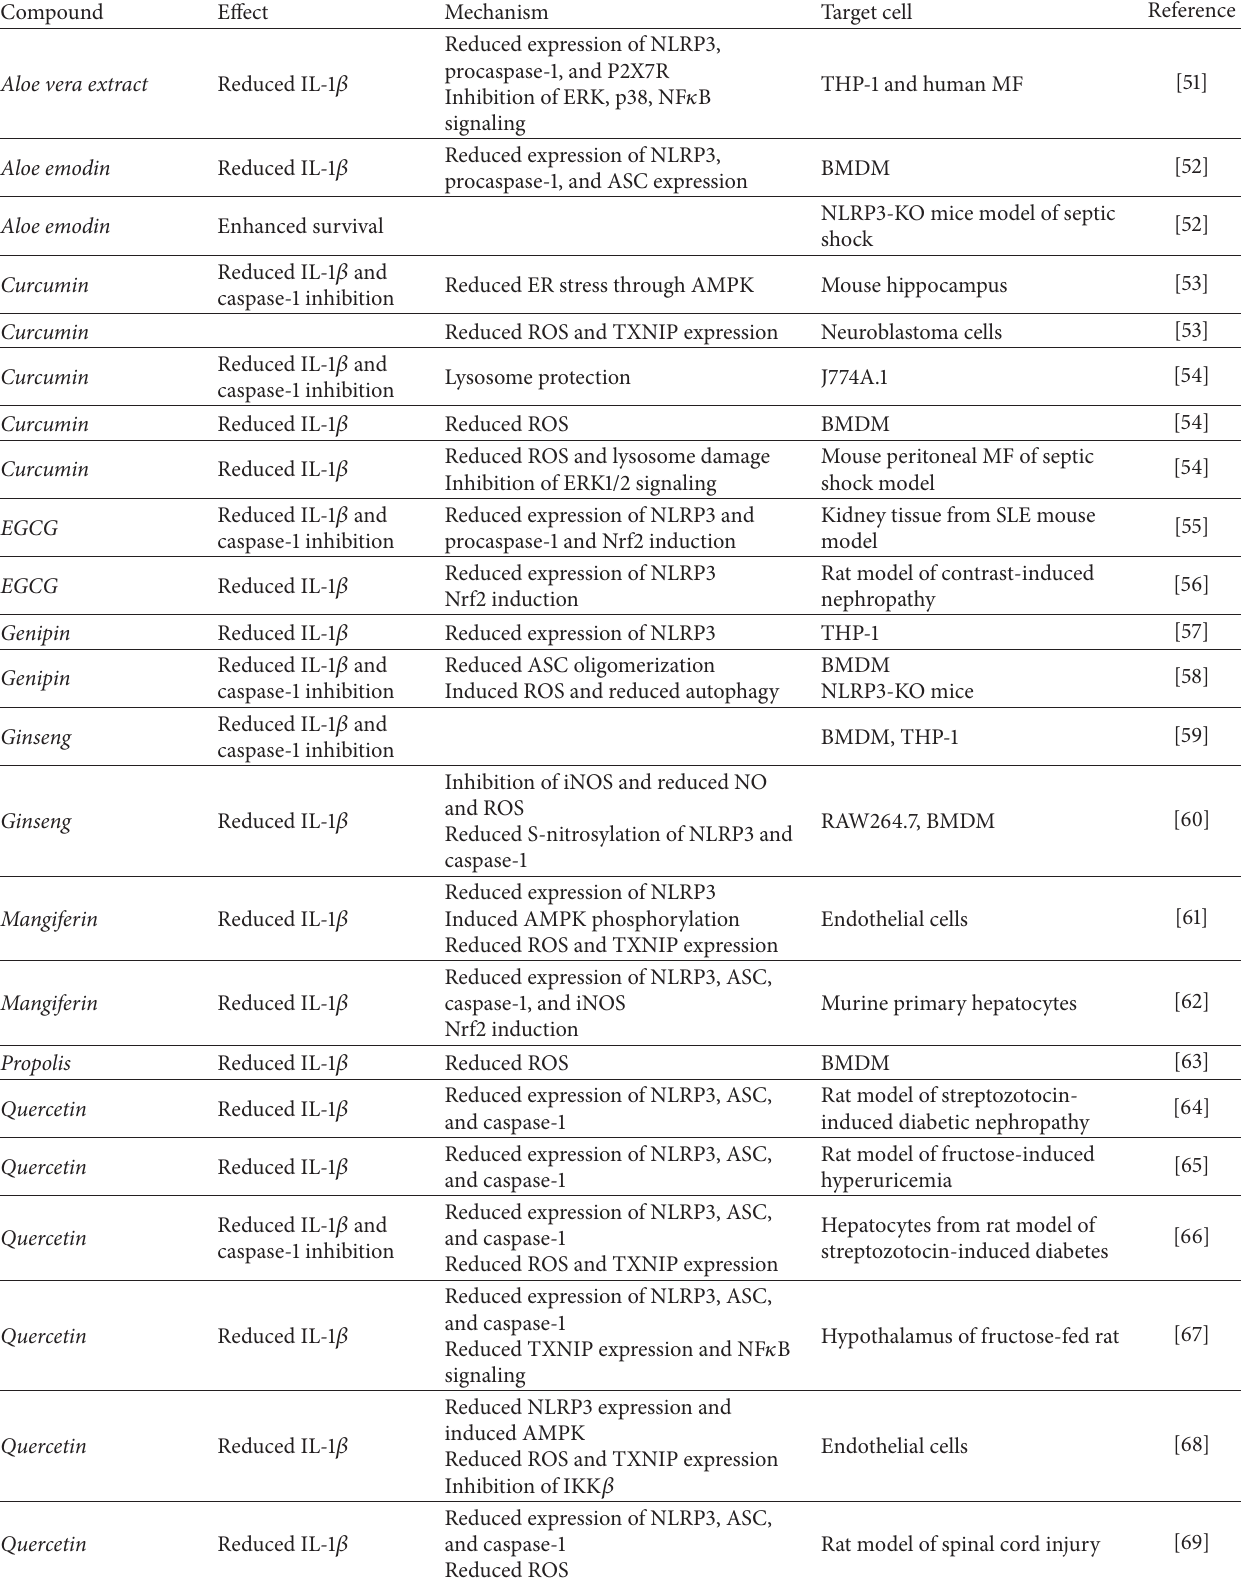
Table 1: Natural compounds effecting NLRP3 inflammasome-mediated IL-1